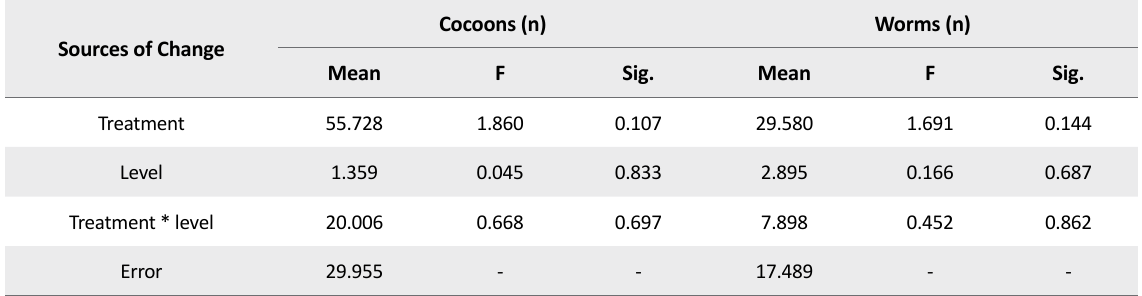
Table 2. ANOVA results for the number of cocoons and worms in different treatments of vermicompost production